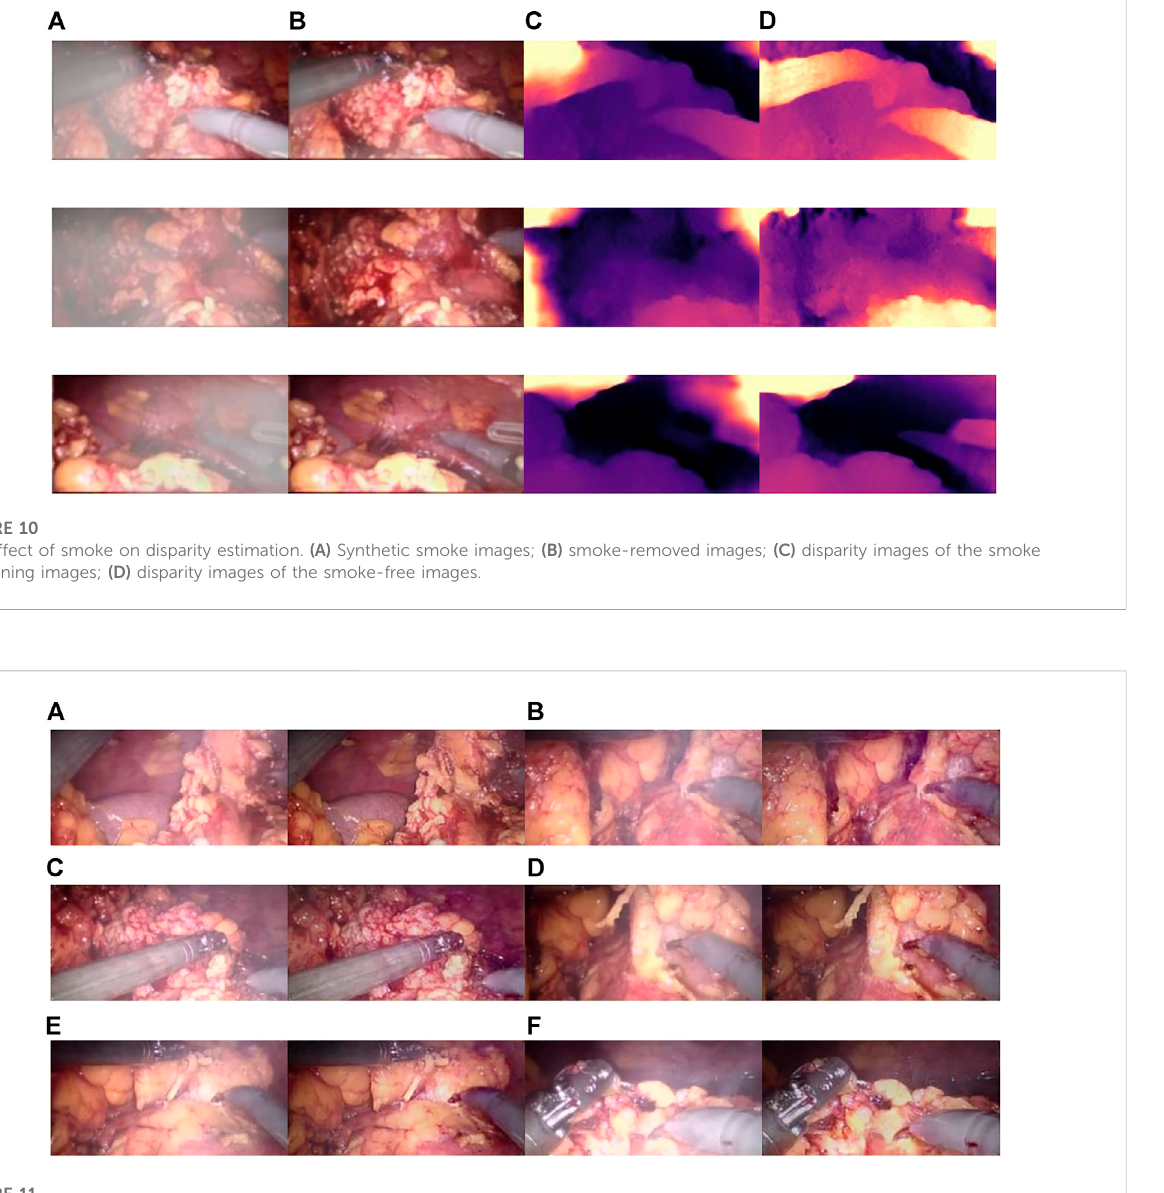
FIGURE 11 Laparoscopic imagesofrealsmokeandimagesafter removal. (A – F) arerandomlyselectedfromtheexperimentalresults.Laparoscopicimages of real smoke (left sub-panels) and images after smoke removal by U-Net + CBAM + Laplace pyramid fusion (right